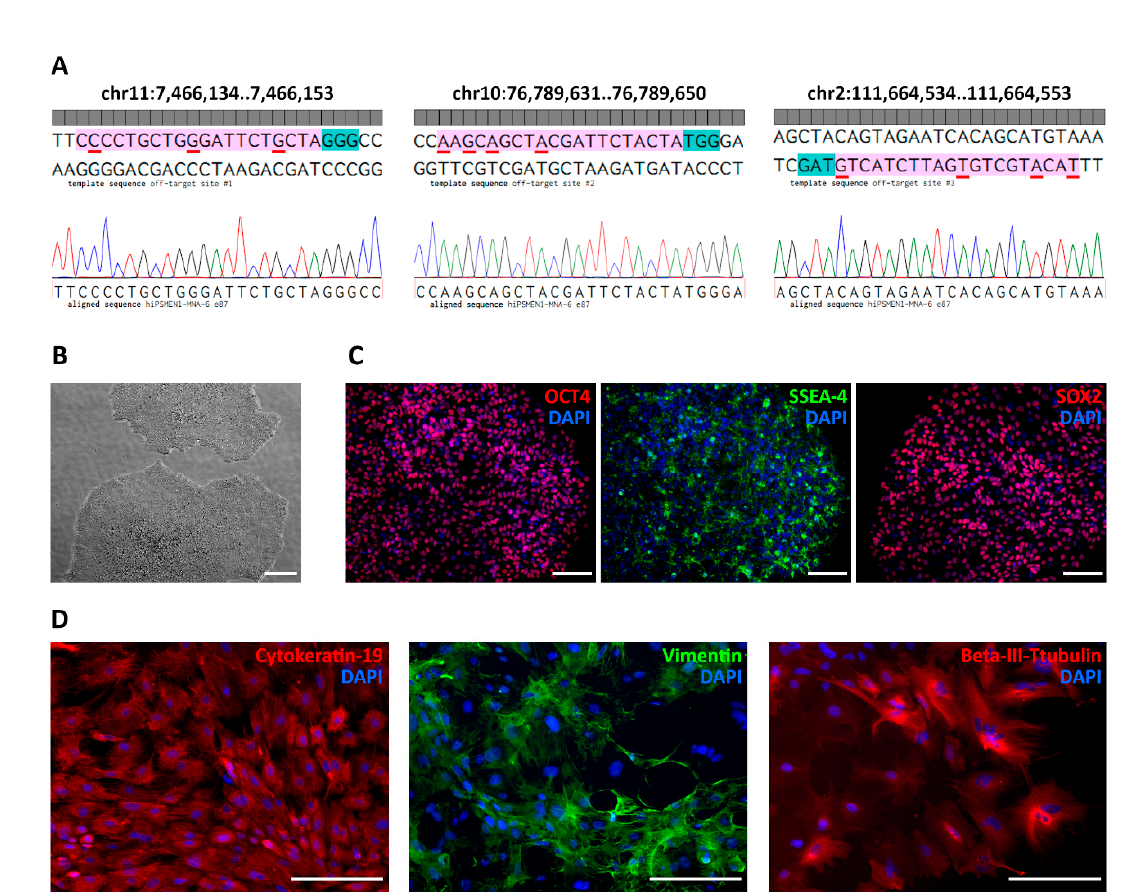
Figure 4. Characterization of gene-corrected isogenic control iPSC line hiPSMEN1-MNA-6 e87 derived from a patient with MEN1 syndrome. ( A ) Analysis of putative genomic off-target loci. Top: plus and minus DNA strands, where the red underlines indicate mismatches; 20-base regions for sgRNA off-target site and PAM sequences are shown in magenta and cyan, respectively. Bottom: sequencing chromatogram of the corresponding region in the genome of hiPSMEN1-MNA-6 e87 cells; ( B ) Representative appearance of the colonies demonstrating a typical human embryonic stem cell-like morphology in hiPSMEN1-MNA-6 e87 culture. Brightfield microscopy image, scale bar represents 100 μ m; ( C ) Immunostaining for pluripotent markers OCT4 (red), SSEA-4 (green) and SOX2 (red) in hiPSMEN1-MNA-6 e87 cells confirming that the pluripotency was maintained. DAPI was used to counterstain cell nuclei (blue). Scale bars represent 100 μ m; ( D ) Differentiation of hiPSMEN1-MNA-6 e87 cells into all three germ layers (endoderm, mesoderm, ectoderm). Immunostaining for Cytokeratin-19 (red), Vimentin (green) and Beta-III-tubulin (red), demonstrating the expression of endodermal, mesodermal and ectodermal markers, respectively. Nuclei were counterstained with DAPI (blue). Scale bars represent 200 μ m.